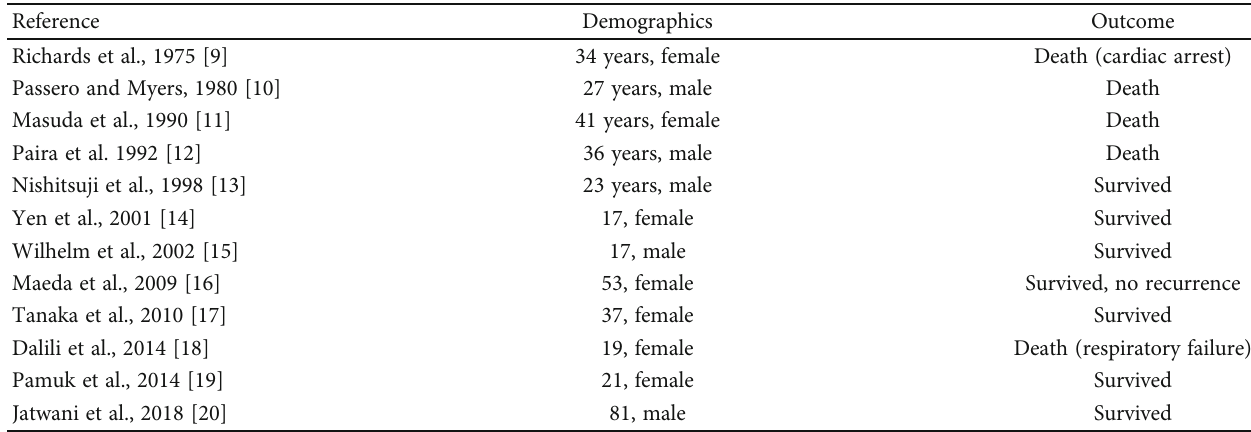
Figure 2: CT of patient XY chest ((a), (b) pneumothorax, (c) pericardial e ff usion, and (d) left lower lobe consolidation). Table 1: Summary of case reports identi fi